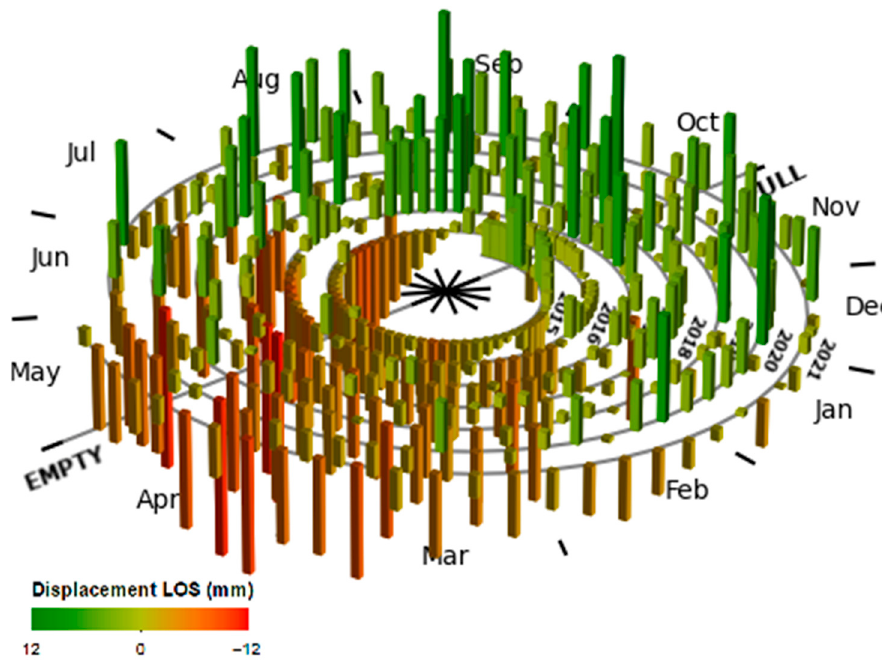
Figure 2. Visualisation of a spiral graph in 3D (taken from [ 16 ]).